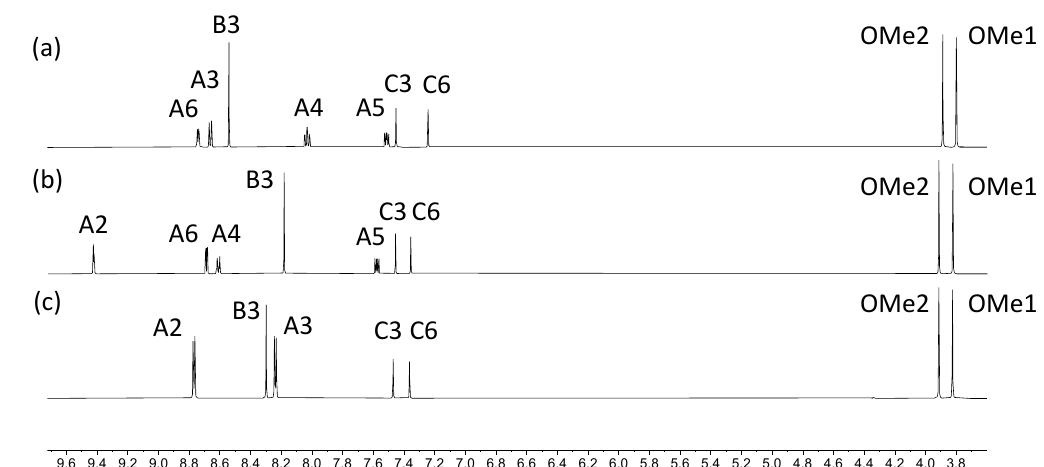
Figure 1. 1 H NMR spectra of compounds ( a ) 1 , ( b ) 3 and ( c ) 4 (500 MHz, DMSO- d 6 , 298 K).